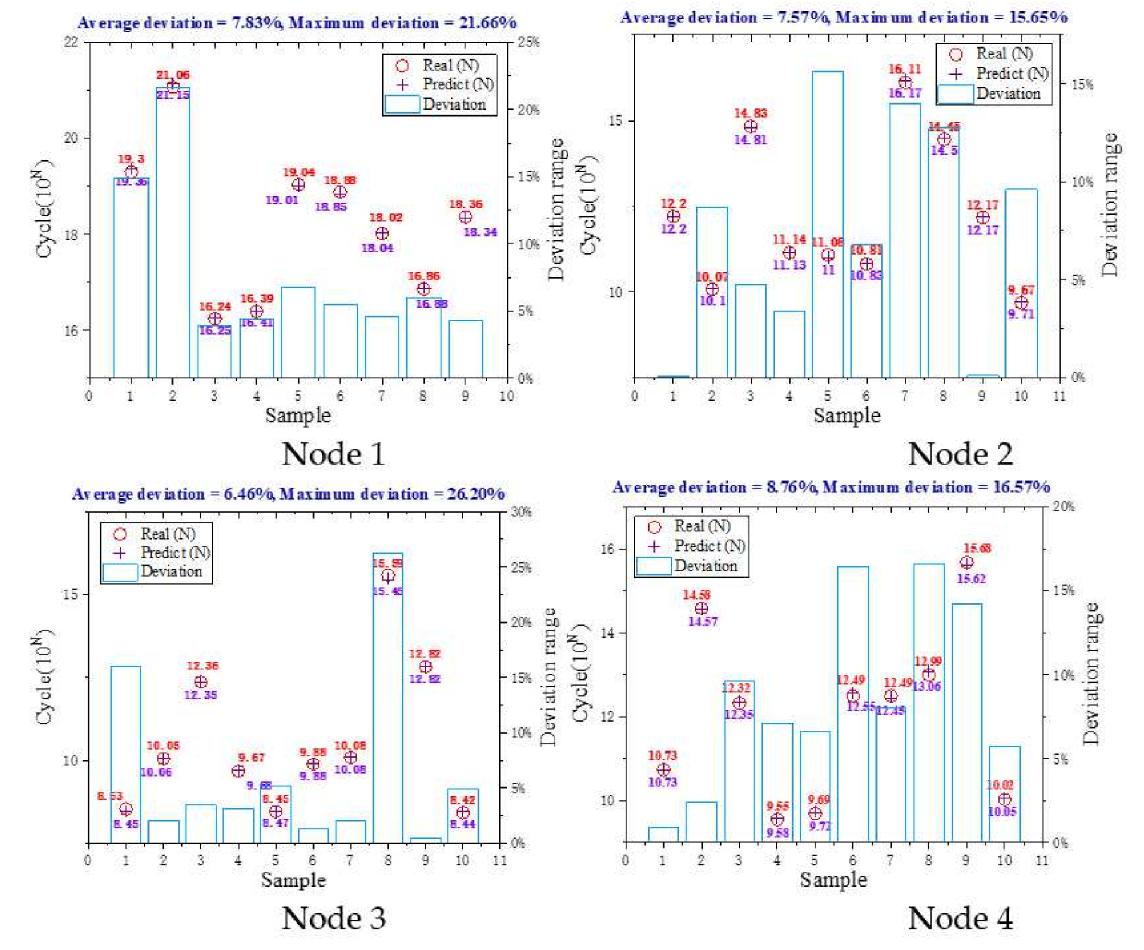
Figure 7. Training and test of RBF